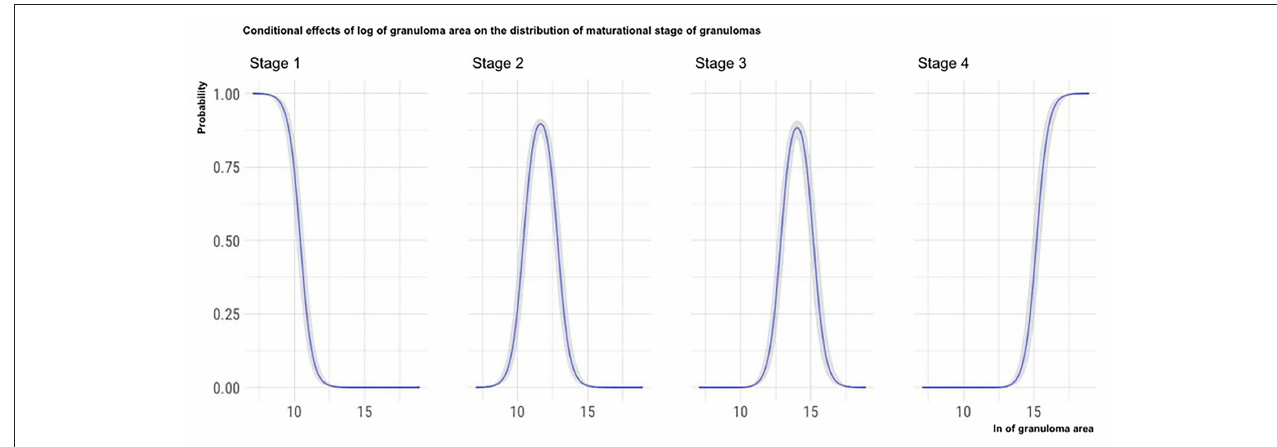
FIGURE 4 | Marginal effects of granuloma size on granuloma histological stage. The figure shows that as the granulomas’ area increases, the possibility that granulomas are classified in the high histological stages increases. Furthermore, the clear separation of the curves indicates that the granulomas’ size can be considered a good predictor of the granulomas histological stage.